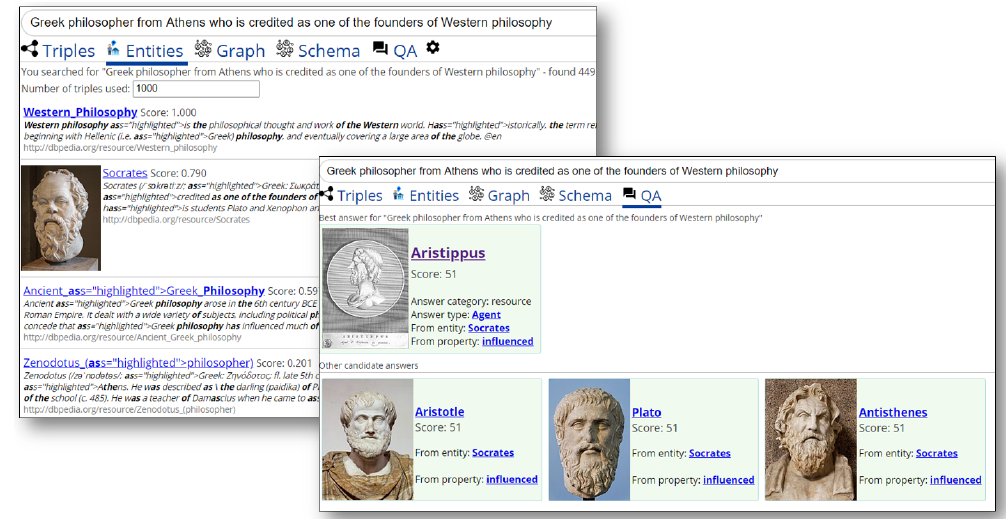
Figure 8. Search results for the query “ Greek philosopher from Athens who is credited as one of the founders of Western philosophy